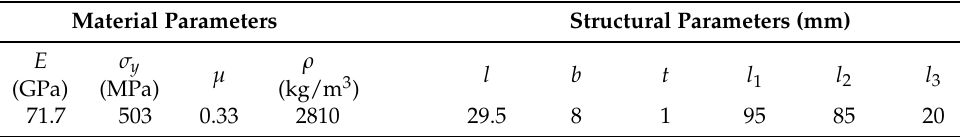
Table 1. Material and Structure